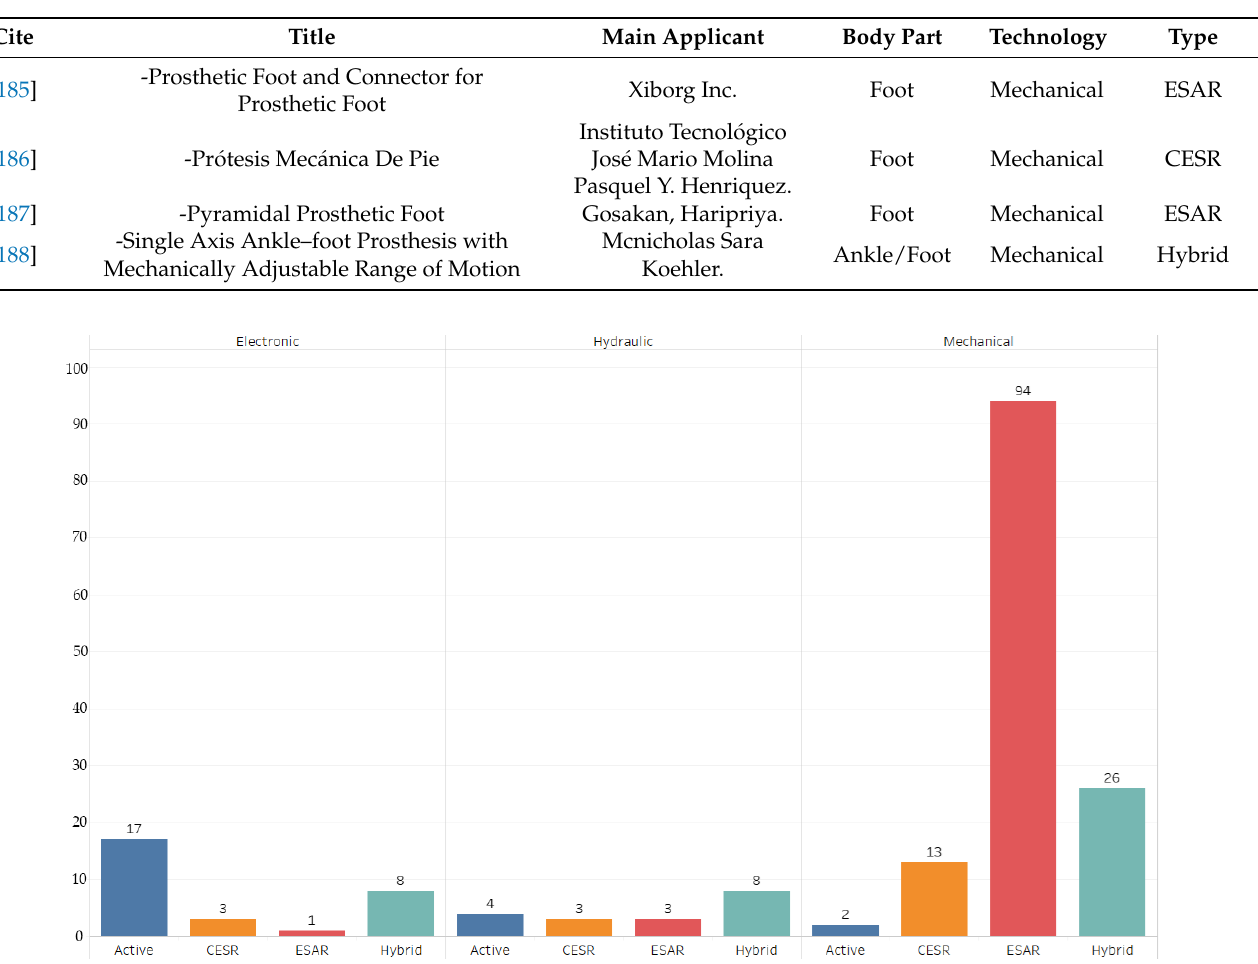
Figure 4. A display of prosthesis types in terms of electronic, hydraulic, and mechanical technology.